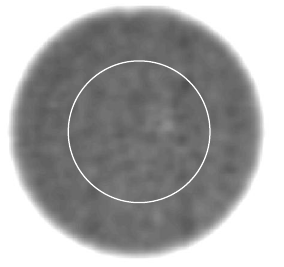
Figure 5: Transaxial 3D brain-mode PET image of a slice through the 9 . 0cm diameter phantom cup. The 5 . 0cm diameter ROI (white circle) was used to calculate the variance as a measure of image noise since it was known to contain a homogeneous distribution of 18 F- FDG solution.